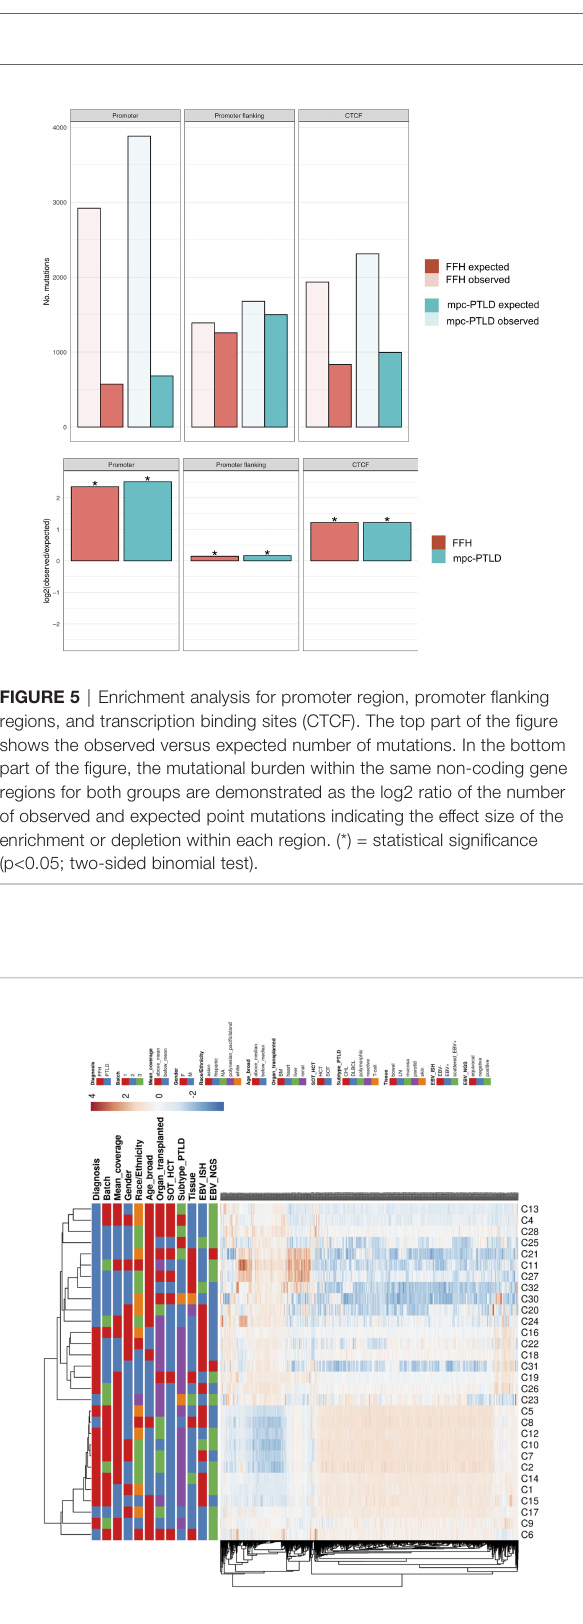
FIGURE 6 | Heatmap hierarchically clustered by Euclidean distance of gene expression for all of the investigated groups (see legend).